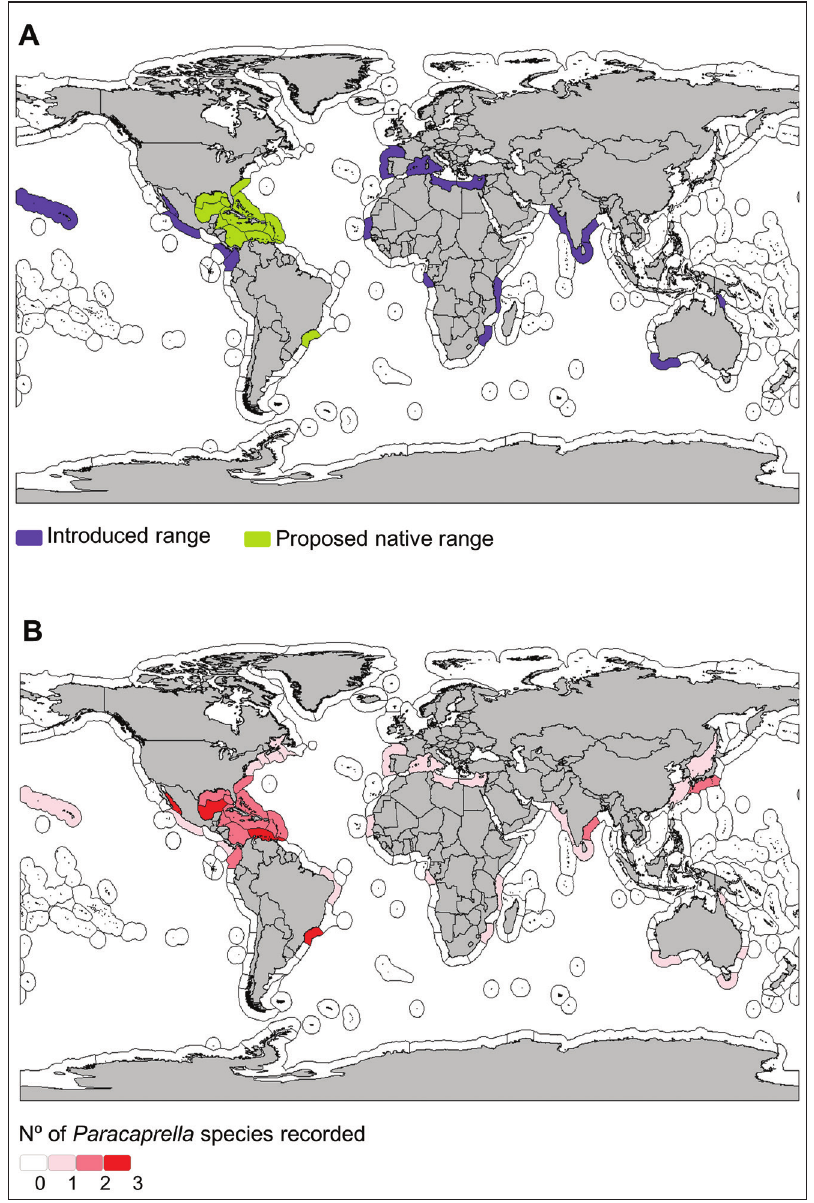
Figure 5. Global distribution of Paracaprella pusilla and the genus Paracaprella a Current worldwide distribution of P. pusilla including its introduced range and the proposed native range. Information based on Ros and Guerra-García (2012) and references therein; Ros et al. (2013c); Ros et al. (2014); Ros et al. (2016a); Alarcón-Ortega et al. (2015); Alfaro-Montoya and Ramírez-Alvarado (2018); and Fersi et al. (2018) b Number of Paracaprella species recorded per marine ecoregions. Information based on Win- field and Ortiz (2013); Mauro and Serejo (2015); Sánchez-Moyano et al. (2015); Lacerda and Masunari (2014). Marine ecoregions follow Spalding et al.